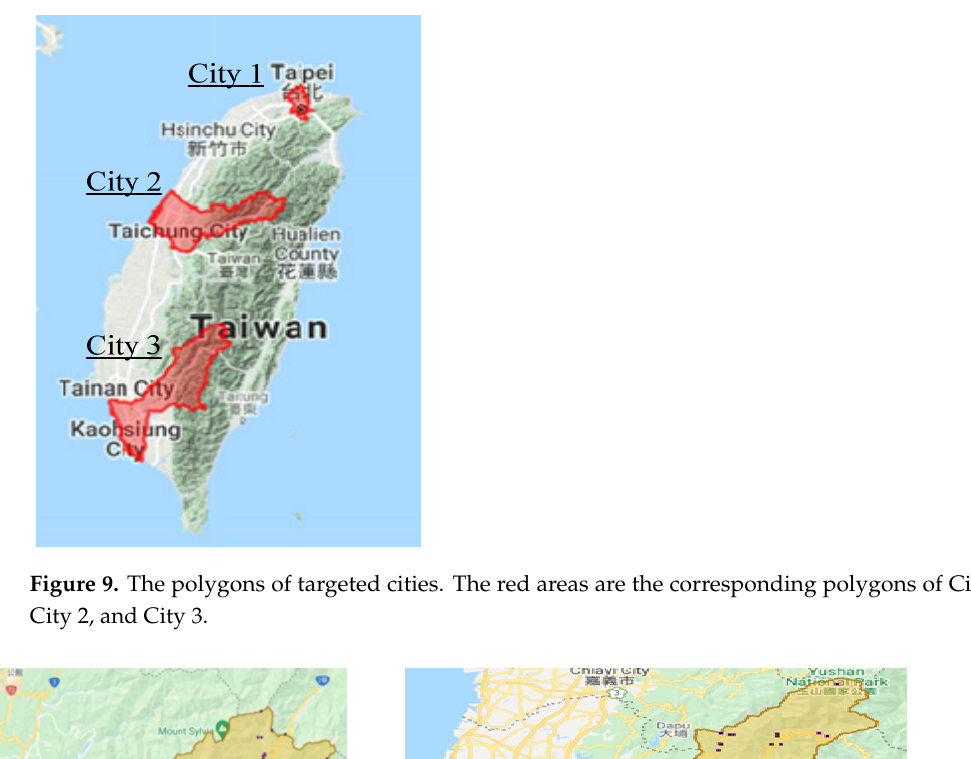
Table 2. Targets in cities with their geographical information. For a targeted city, the “target” rep- resents the number of targets, “area” provides the area in square kilometers, “population” refers to the population in millions of people, “area density” refers to the number of targets per square kilometer, and “population density” refers to the number of targets per million people.